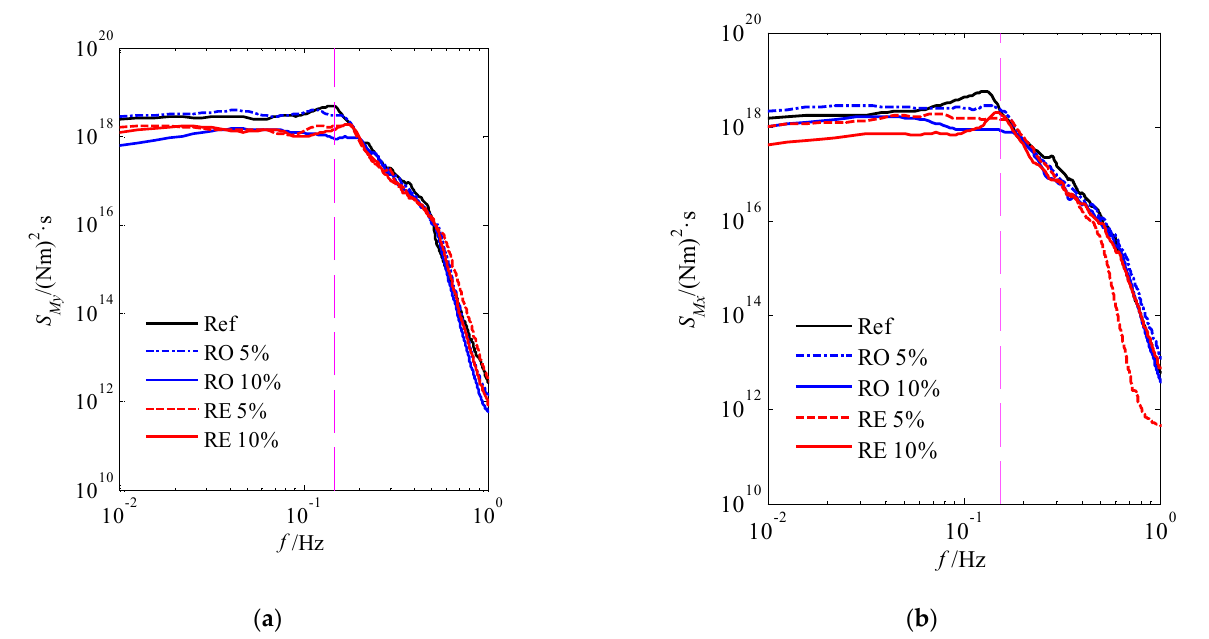
Figure 5. Moment spectra in critical azimuth: ( a ) S My at azimuth 0°. ( b ) S Mx at azimuth 270°.